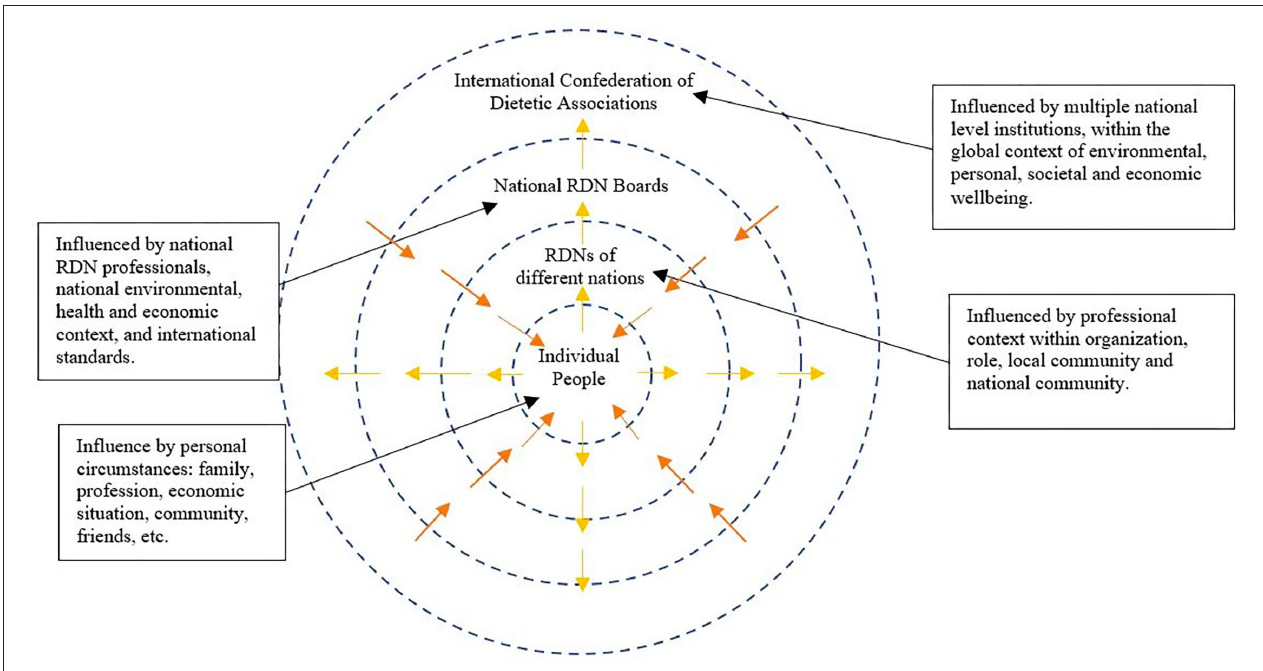
FIGURE 1 | Influence across scales of the dietetics